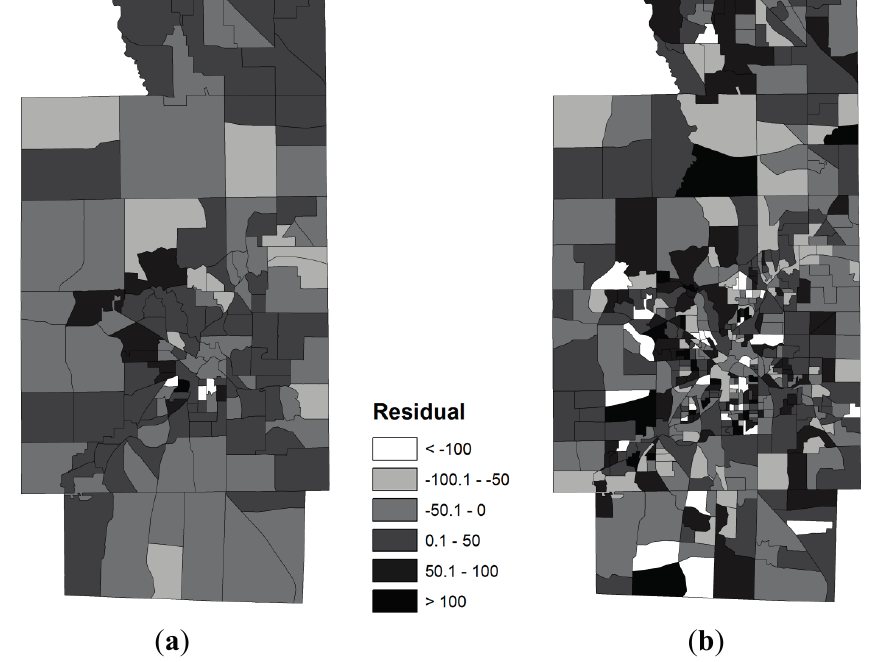
models, ObRates = function (RGEBA, MEDINC, RUNEMP). ( a ) Census Tracts, ( b ) Census Block Groups.